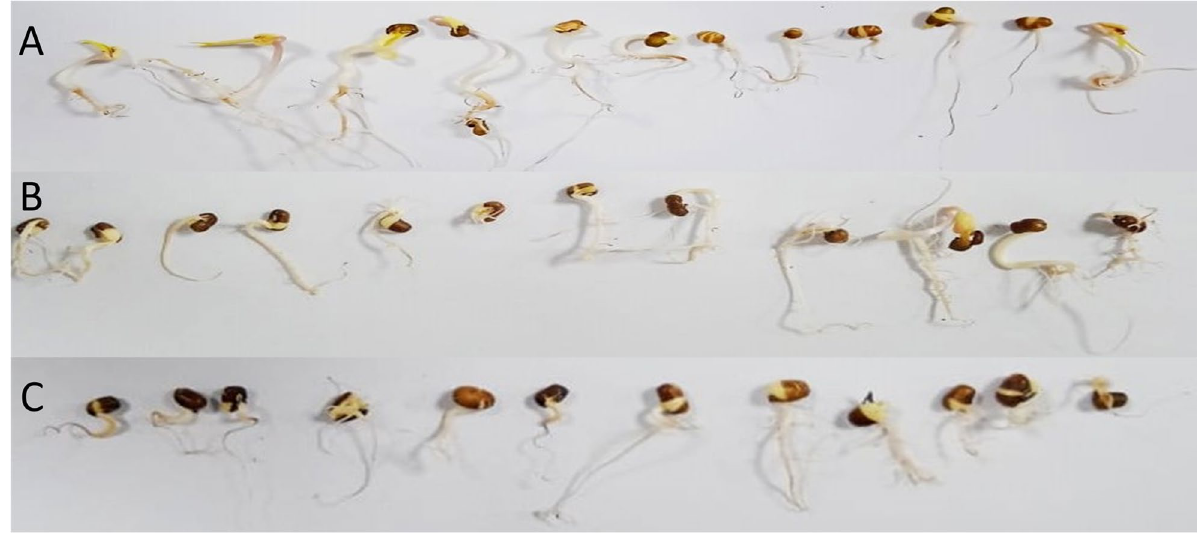
Figure 7. Germination of mung bean seeds ( A ) control, ( B ) seedes primed with biological ZnO nanoparticle. ( C ) Seeds primed with ZnO chemical nanoparticles. Name of the